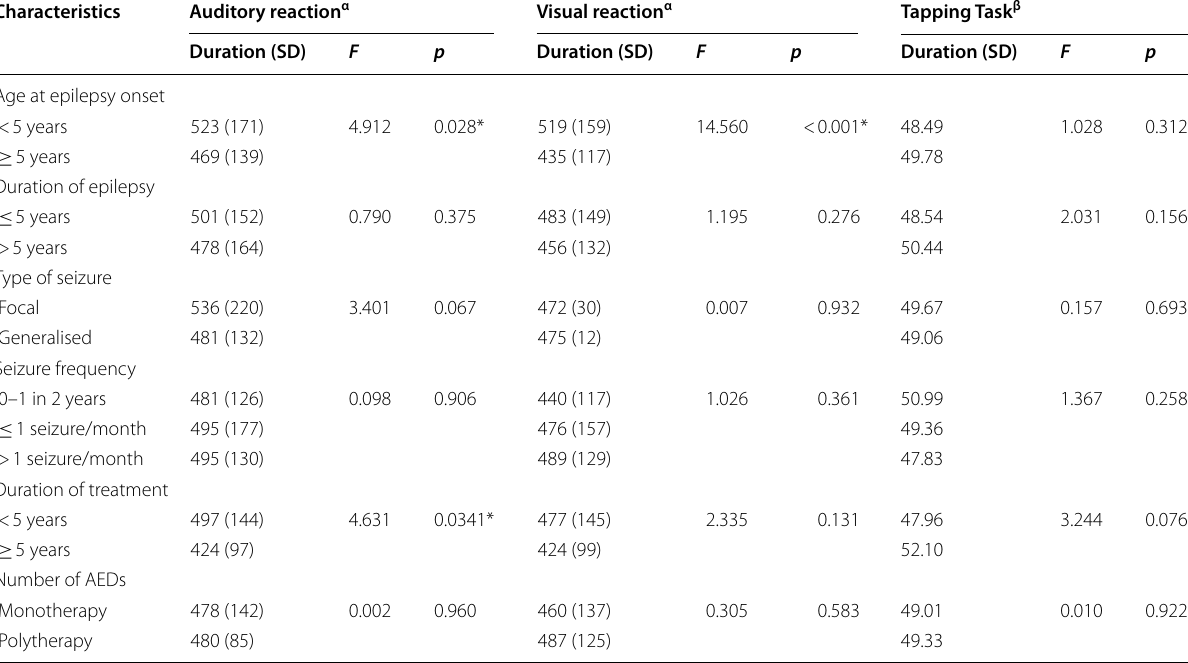
*Significant at p < 0.05; α—lower values indicate better performance; β—higher values indicate better performance